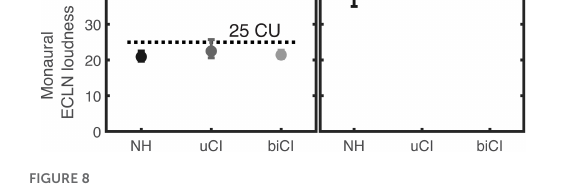
FIGURE8 Monaural ECLN loudness that evoked 25CU (left panel) and 45CU (right panel) loudness rating of the binaural modECLN for the different listener groups. Values were extracted from the regression lines of each listener and the error bars show mean and range of the